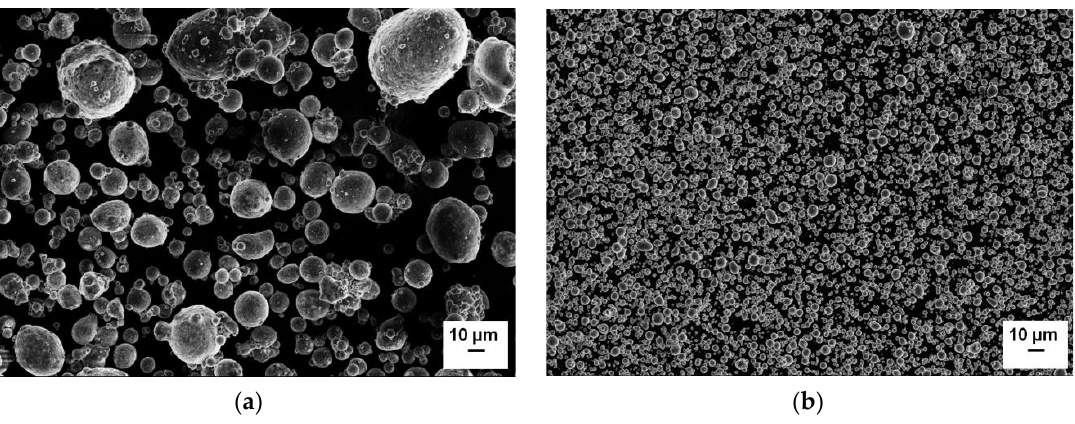
Figure 1. Morphology of the Al powders: ( a ) coarse and ( b ) fine.